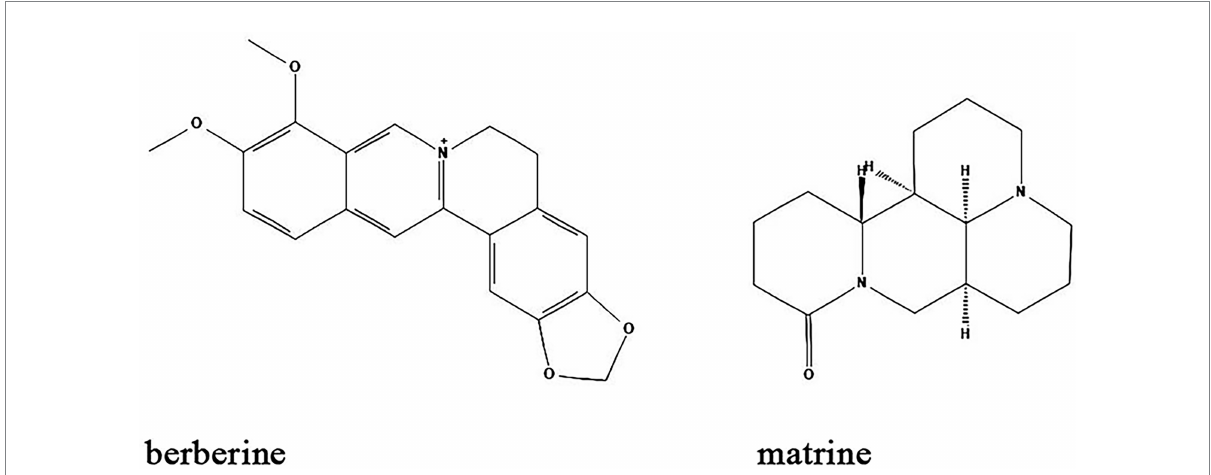
FIGURE 6 Chemical structures of the different alkaloids that inhibit biofilm formation via QS. ChemDraw software has been utilized to draw the chemical structures of the molecules.